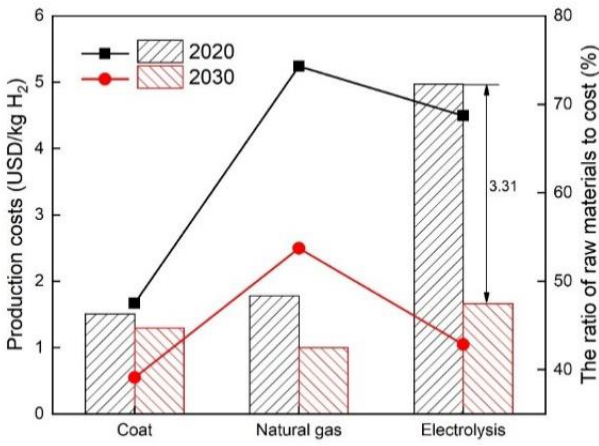
Figure 4. Forecast of raw material cost changes.